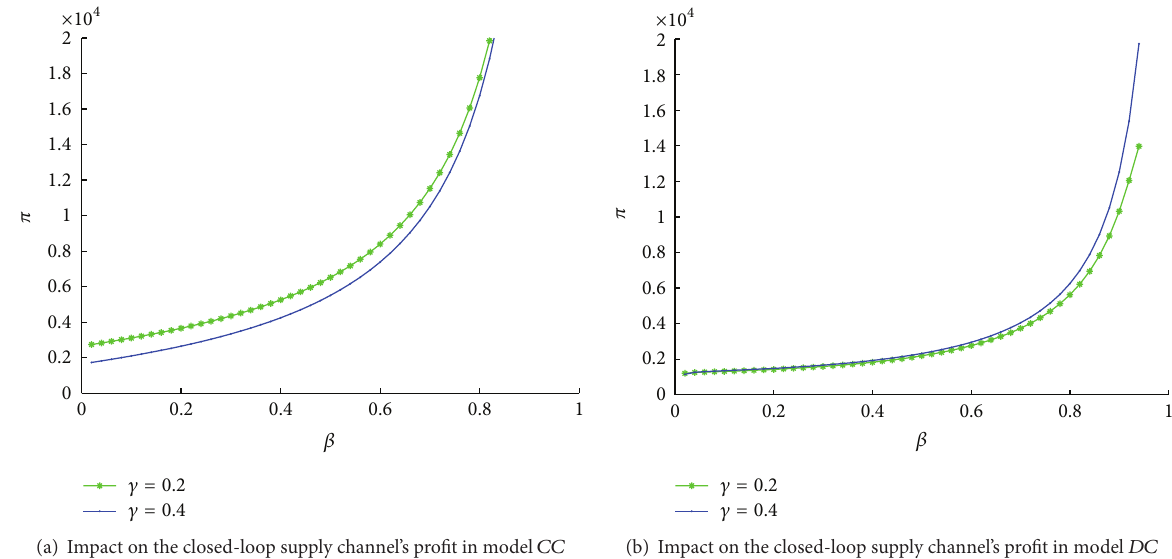
Figure 8: Impact of the retailing and recycling substitution effects on closed-Loop supply chain’s